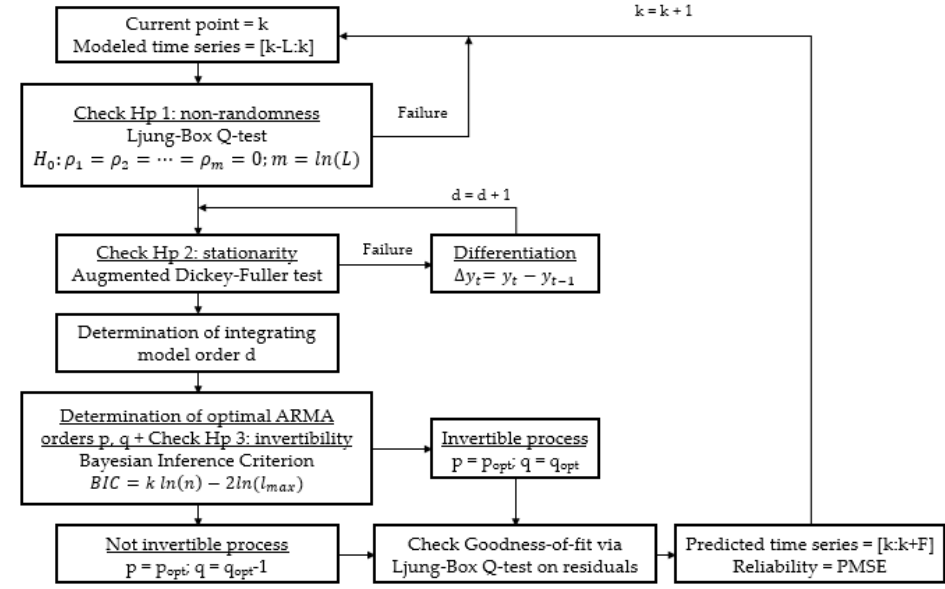
Figure 5. Proposed algorithm’s functioning for general kth iteration. Models’ orders p, d, q are automatically set through statistical inference hypothesis tests, in order to avoid manual intervention.